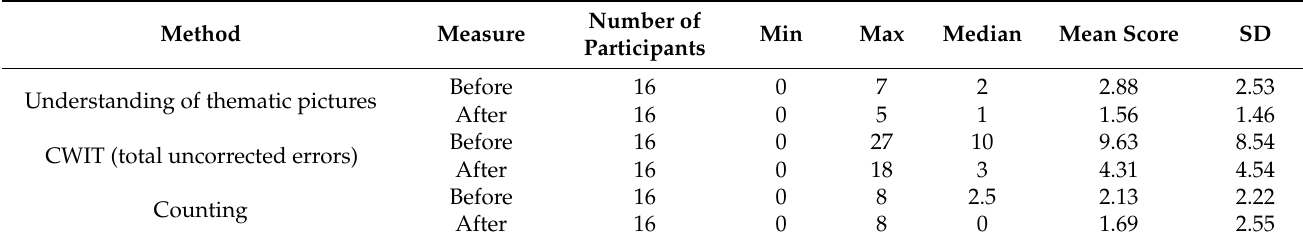
Table 3. Total scores across methods which differed significantly before and after the training sessions ( p ≤ 0.05).